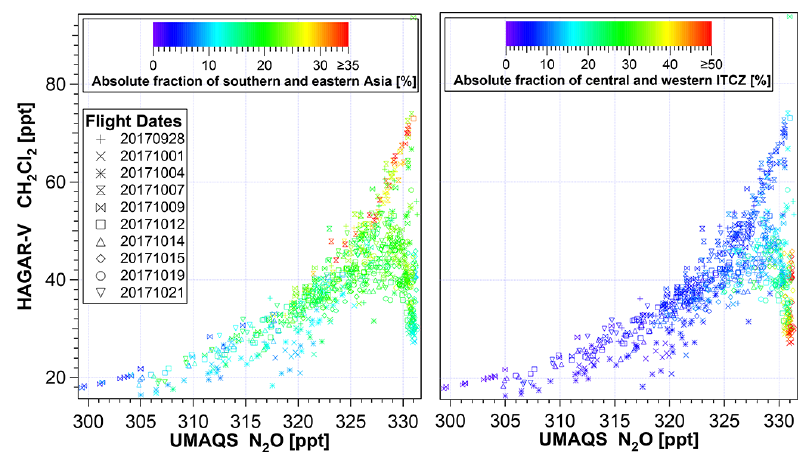
Figure A1. CH 2 Cl 2 –N 2 O relationship color coded with different surface origin tracers. The tracer fractions shown are relative to the other surface origin tracers including the fraction of air that had already been above the model boundary layer at the initialization of the model simulation on 1 May 2017.